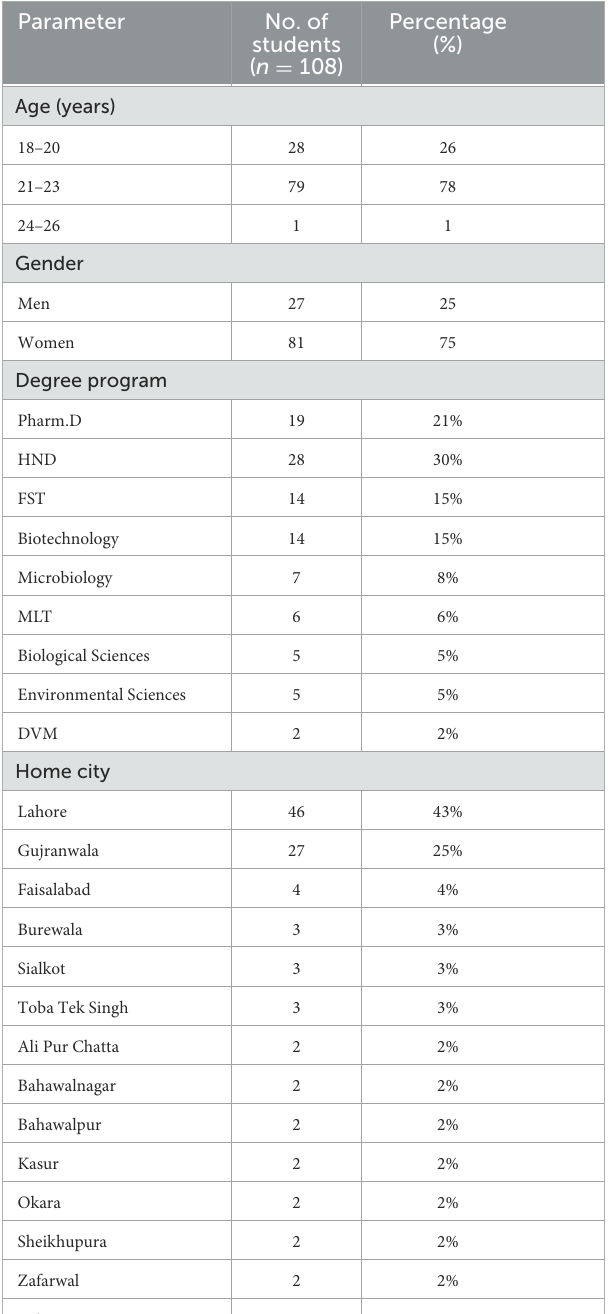
TABLE 1 Frequency distributions of